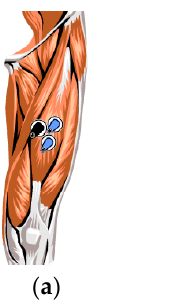
Figure 1. Muscle and electrode location. ( a ) Shows the electrode positions for the RF, ( b ) shows the electrode positions for the